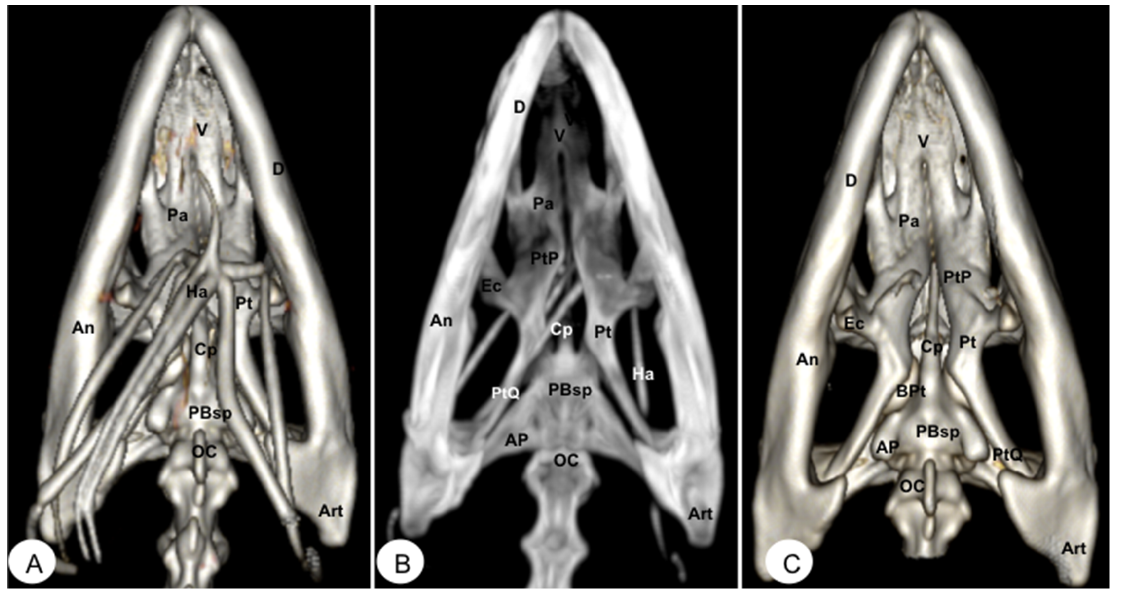
Figure 9. Head of Iguana iguana. ( A ) Ventral VR image. ( B ) Ventral MIP image. ( C ) Ventral VR image without Hyoid apparatus . D: Dentary bone. An: Angular bone. Art: Articular bone. V Vomer. Pa: Palatine bone. Pt: Pterygoid bone. Ec: Ectopterygoid. PtP: Pterygoid palatine process. PtQ: Pterygoid quadrate process. BPt: Basipterygoid process. PBsp: Parabasisphenoid bone. Cp: Cultriform process. OC: Occipital condyle. Ha: Hyoid apparatus. AP: Alar process.